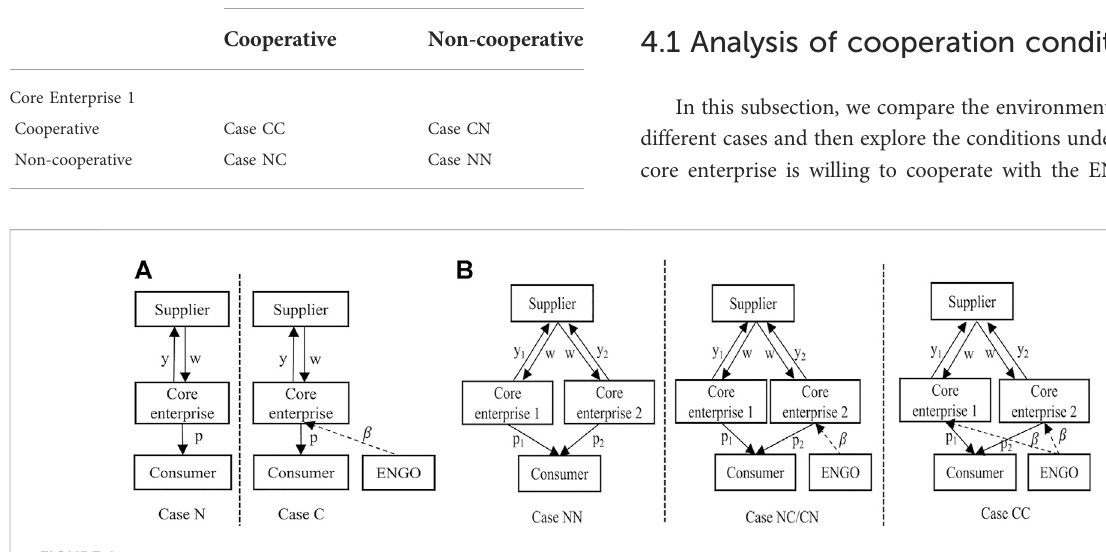
FIGURE 1 System structures of two scenario. (A) Monopoly scenario. (B) Duopoly